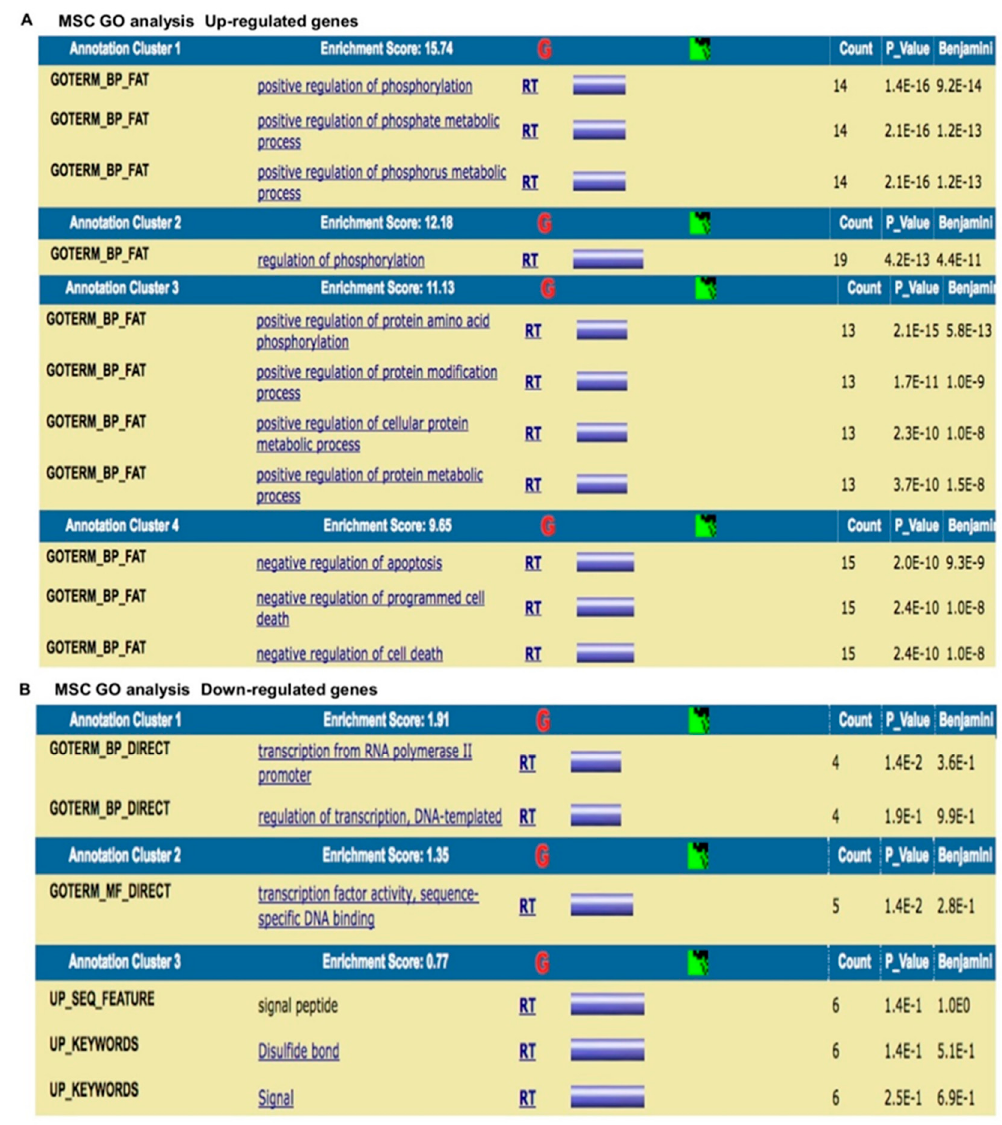
Figure 11. Gene Ontology analysis of genes related to MSCs involved in tissue homeostasis. ( A ) Up-regulated genes are involved in intense kinase activity. ( B ) Down-regulated genes are involved in transcription process.